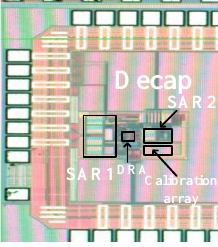
Figure 8. Chip photo of the ADC.